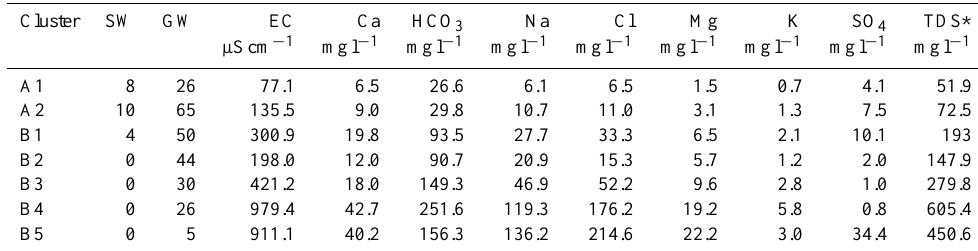
Table 2. Assignment of surface water (SW) and groundwater (GW) monitoring sites to hydrochemical clusters and mean values of chemical parameters for each cluster.